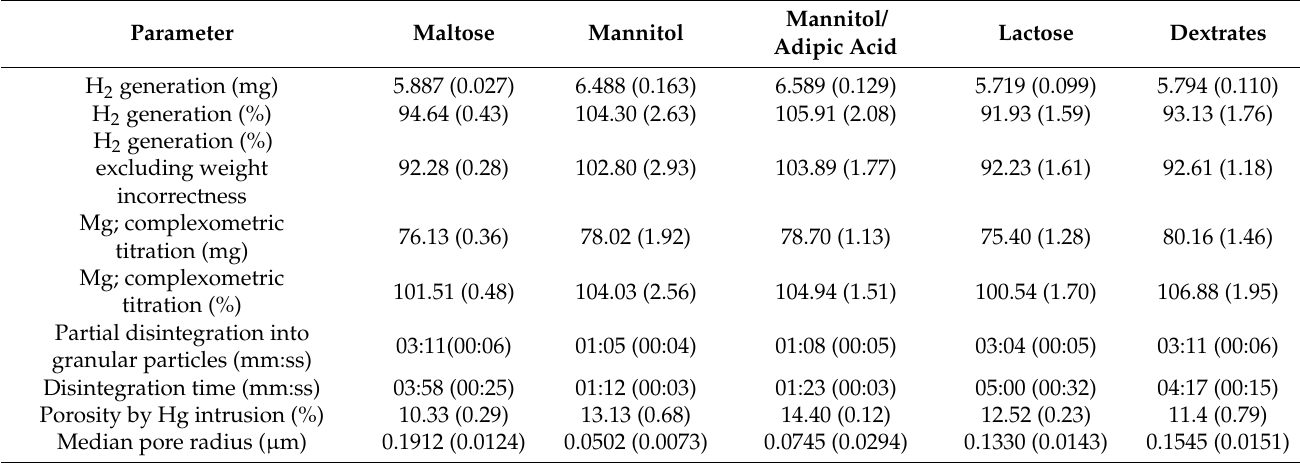
Table 1. Content, kinetic hydrogen generation, and disintegration displayed as mean and (SD).